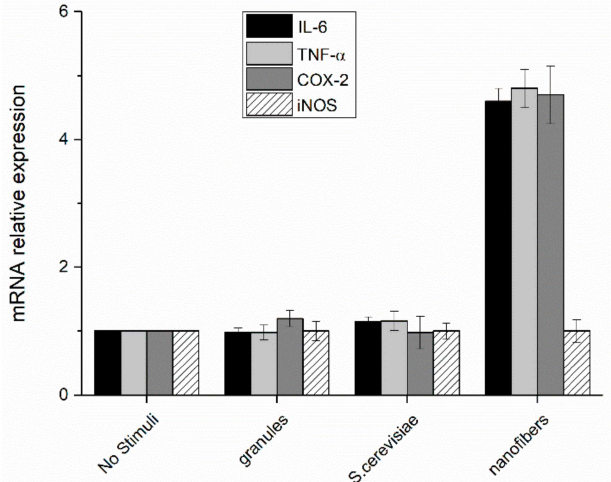
Figure 9. Relative expression of interleukin-6, tumor necrosis factor alpha, cyclooxygenase 2, and inducible nitric oxide synthase in PBM cells after 24 h stimulation with paramylon granules, S. cerevisiae preparation, and paramylon nanofibers. Results were expressed as fold-increase respect to control and plotted as the mean ±